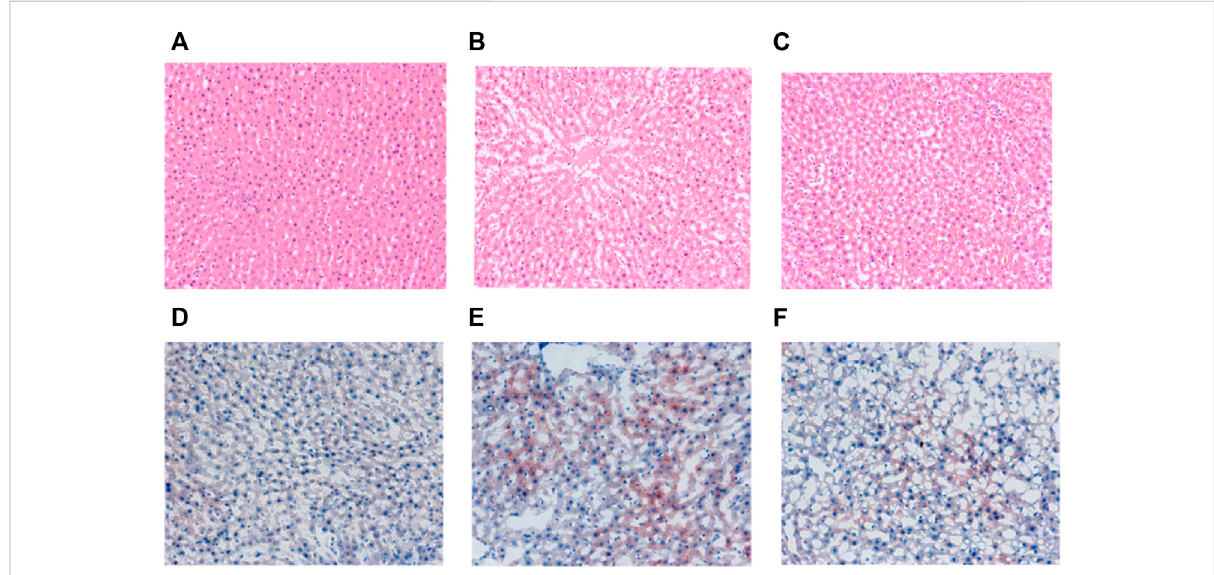
FIGURE 3 Representative H&E staining (magni fi cation, × 200) of liver sections from the C (A) , M (B) and S (C) groups and oil red staining (magni fi cation, × 200) of liver sections from the C (D) , M (E) and S (F) groups at the end of 6th